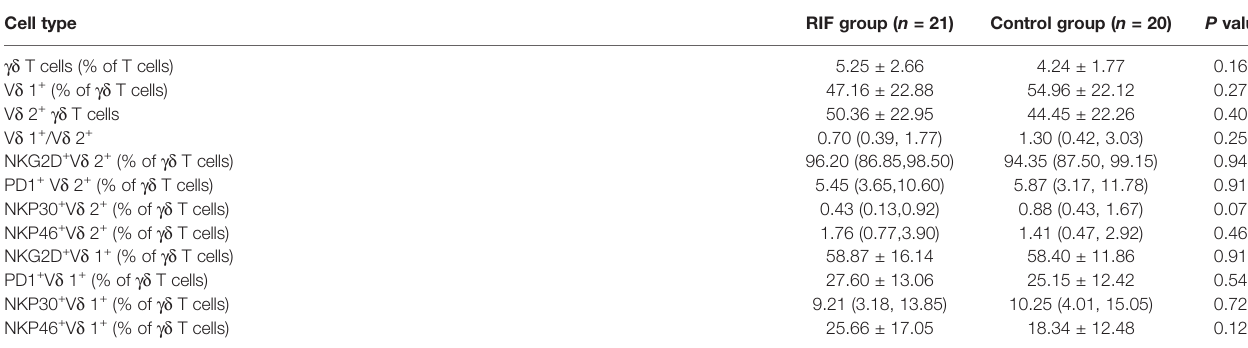
TABLE 4 | Comparisons of NK cell subsets between the RIF and control groups.